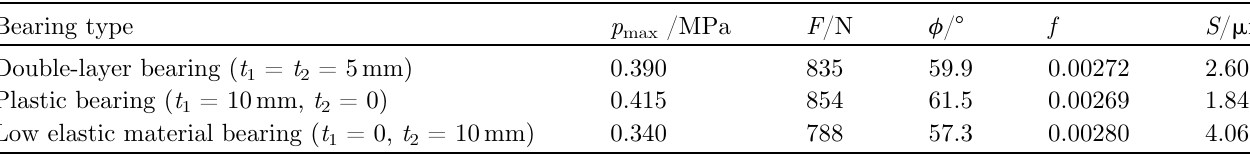
Table 1. The lubrication performance of the bearings. Bearing